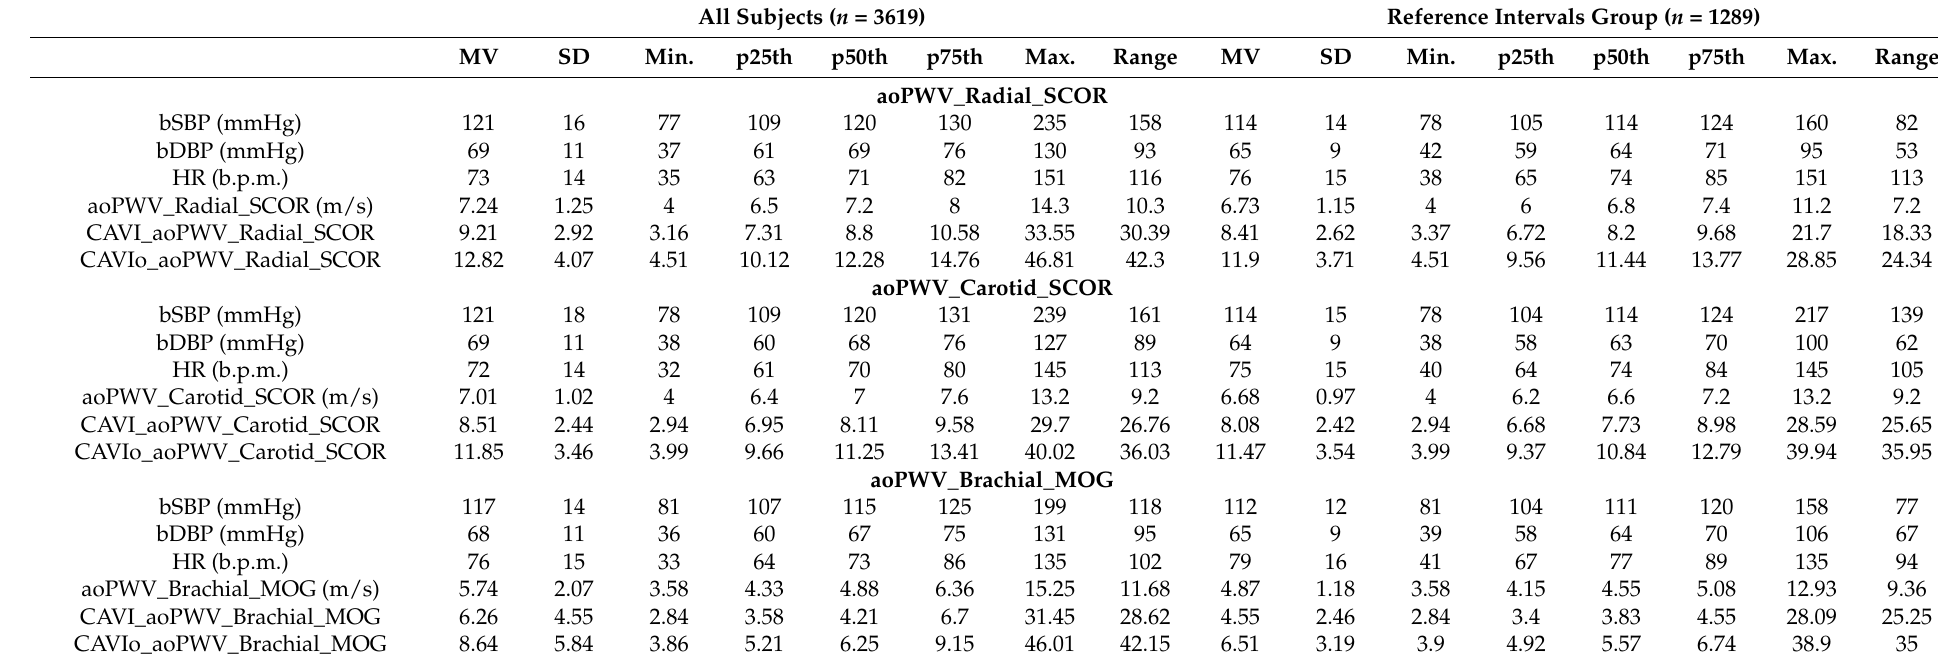
Abbreviations: similar to Table 1. HR: heart rate. Other abbreviations: see the text. Table 4. Concordance correlation coefficients between PWV parameters (Reference Interval